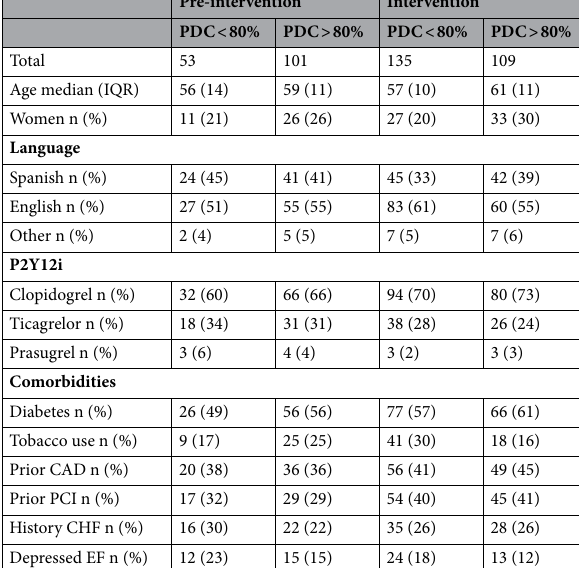
Table 4. Demographics stratified by PDC above or below